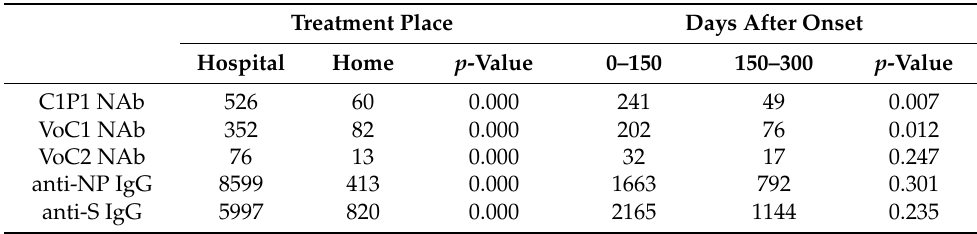
Table 1. Geometric mean titers and p -values when the data is divided into subgroups based on the time after the onset of symptoms and disease severity. Treatment Place Days After Onset Hospital